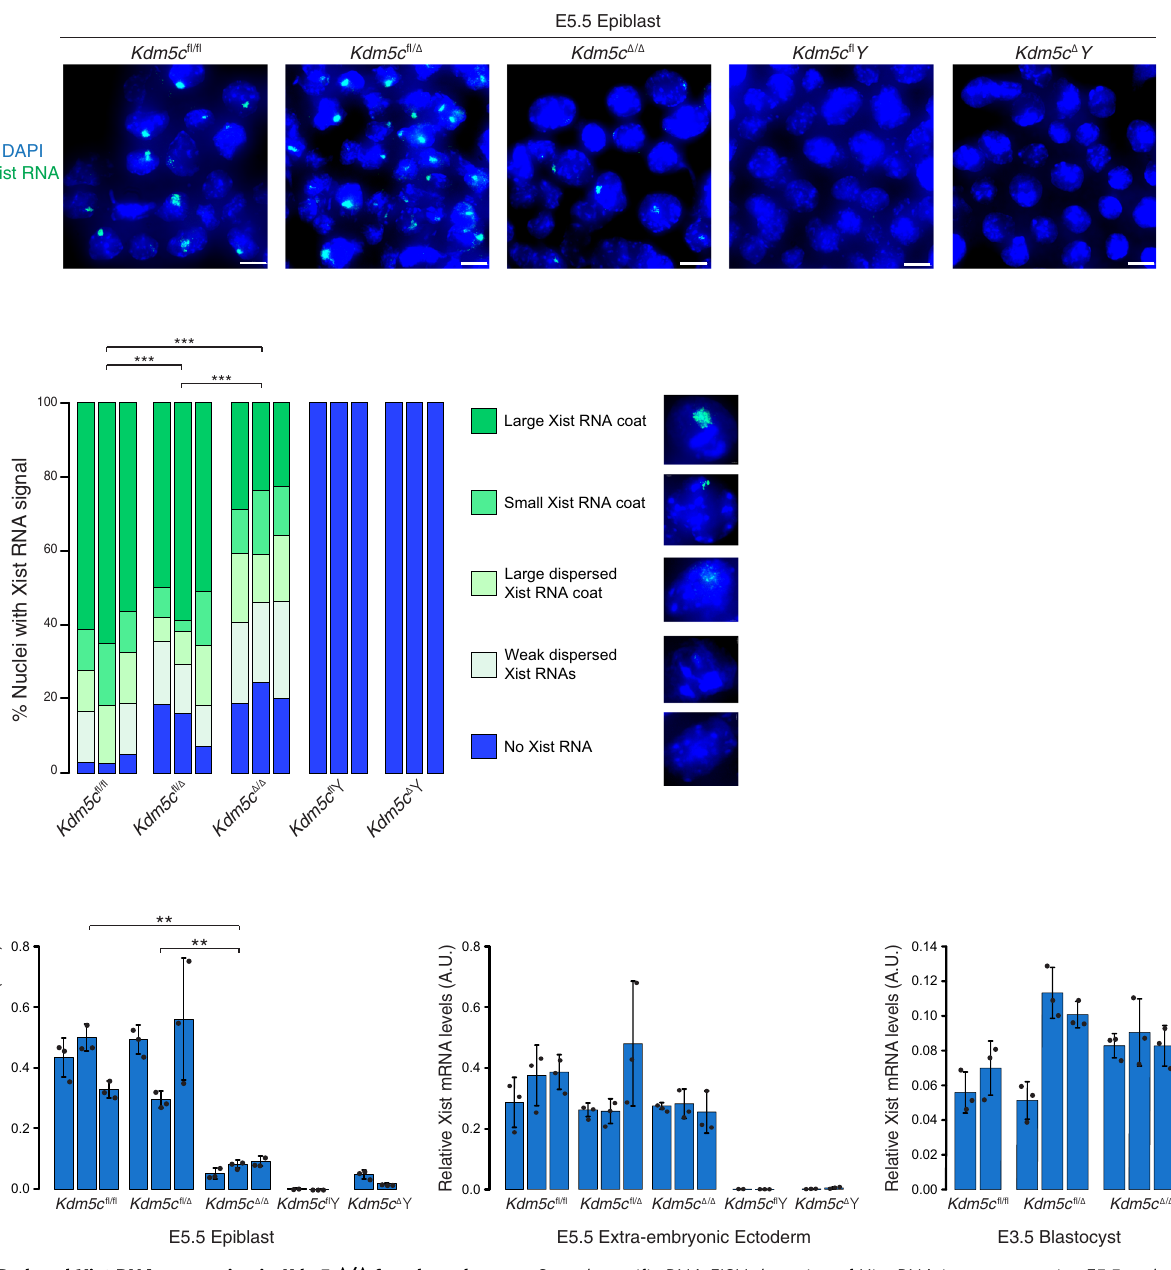
Fig. 2 Reduced Xist RNA expression in Kdm5c Δ / Δ female embryos. a Strand-speci fi c RNA FISH detection of Xist RNA in representative E5.5 embryonic epiblast cells. Nuclei are stained blue with DAPI. Scale bars, 10 μ m. RNA FISH analysis was performed on 3 embryos/genotype with similar results. b Quanti fi cation of Xist RNA-coated nuclei in the E5.5 epiblast cells. Number of nuclei counted in each of the three embryos/genotype: Kdm5c fl / fl , n = 36, 77, and 80; Kdm5c fl / Δ , n = 76, 68, and 55; Kdm5c Δ / Δ , n = 128, 139, and 84; Kdm5c fl Y , n = 150, 200, and 100; Kdm5c Δ Y , n = 100, 93, and 85. P values, Chi- square test between female genotypes. * P ≤ 0.05; ** P < 0.01; *** P < 0.001. See Supplementary Table 1 for Welch ’ s two-sided t test for all pairwise statistical comparisons. c Relative quanti fi cation of Xist RNA by RT-qPCR in E5.5 epiblasts, E5.5 extra-embryonic ectoderm, and E3.5 embryos. Each bar in the graph represents an individual E5.5 embryo fragment or E3.5 embryo analyzed by RT-qPCR in triplicate. Data are presented as mean ± standard deviation between technical replicates. P values, Welch ’ s two-sided t test on Δ Ct values of biological replicates. * P ≤ 0.05; ** P < 0.01; *** P < 0.001. Selected pairwise comparisons are shown. See Supplementary Table 2 for all pairwise statistical comparisons. See also Supplementary Fig. 1b. Source data are provided as a Source Data fi KDM5D proteins, on the other hand, exhibited Xist RNA con fi rmed the presence of a single X chromosome in these cells expression levels similar to X Δ Tsix Y cells (Fig. 4d). Reciprocally, (Fig. 4d, e and Supplementary Table 6). These results are con- the loss of KDM5C in X Δ Tsix ; Δ Kdm5c Y cells signi fi cantly reduced sistent with our hypothesis of a dose-dependent induction of Xist ectopic Xist RNA expression relative to X Δ Tsix Y cells ( P = 0.012; by KDM5C. Note that since Tsix is mutated in the X Δ Tsix Y Fig. 4d and Supplementary Table 6). Xist RNA coating assayed by EpiLCs 10,65,66 , these data rule out indirect induction of Xist by KDM5C-mediated suppression of Tsix . RNA FISH recapitulated the RT-qPCR data and DNA FISH